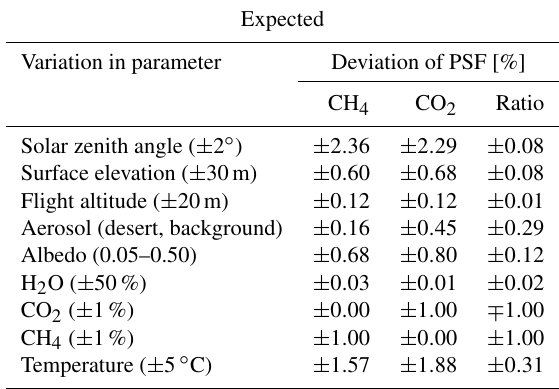
Table A2. Sensitivity of the retrieved profile scaling factors (PSFs) to the input parameters for the radiative transfer model (RTM) simu- lations according to expected variations during one flight on 7 June. The deviations for the PSFs of CH 4 , CO 2 , and the ratio CH 4 to CO 2 are again given relative to the background column. The parameters for the true or basic scenario are listed in Table A1, 7 June, using a flight altitude of 3.16km and a solar zenith angle of 39.4 ◦ . Not all values deviate symmetrically around 0%; therefore, the worst case scenario is always